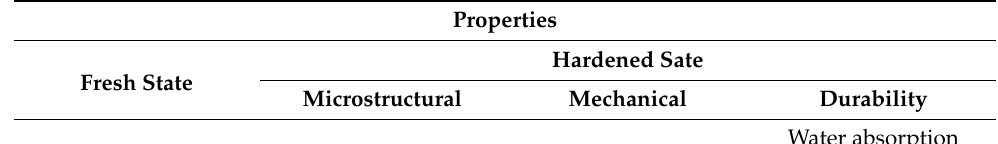
Table 1. Properties of PC-based